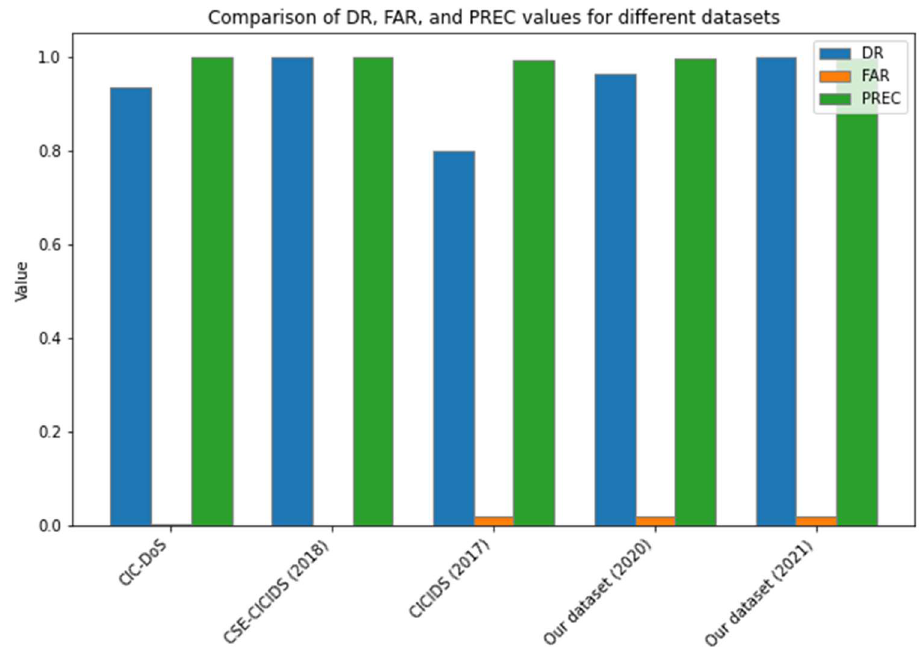
Figure 6. System performance graph. Table 6. Algorithm performances.